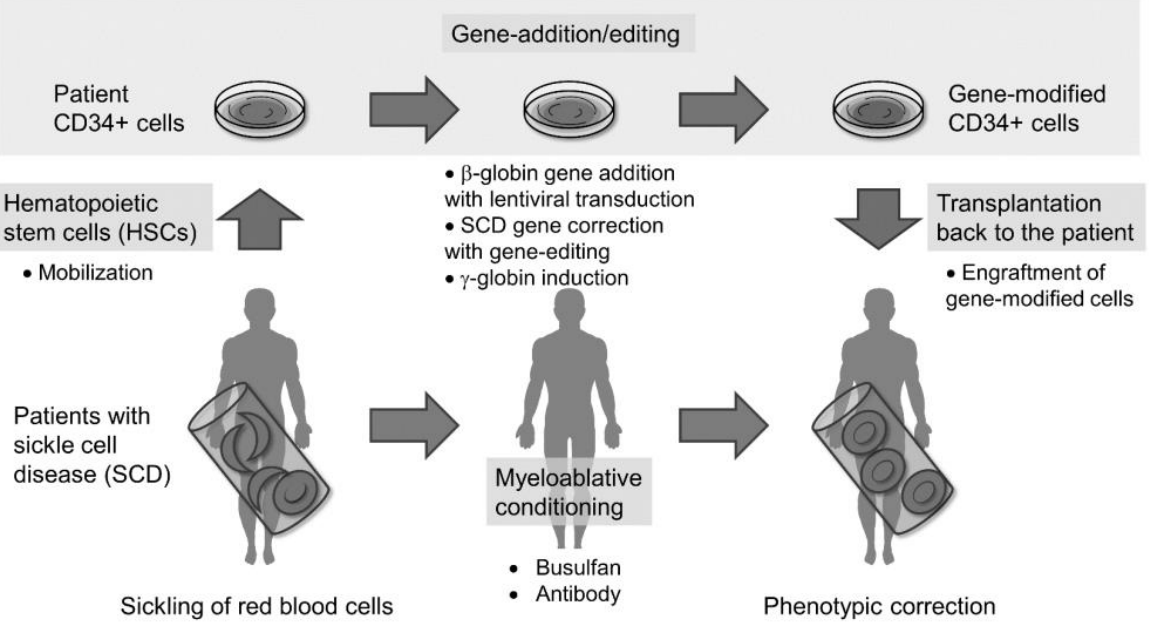
Figure 1. Overview of hematopoietic stem cell (HSC)-targeted gene therapy in sickle cell disease (SCD). A schema of discussion points in autologous HSC therapy with gene addition/editing in SCD.